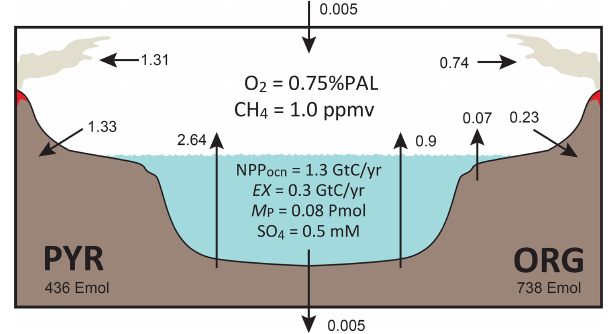
Figure 19. Schematics of global redox (O 2 ) budget for the f P = 1 . 6% ( = 10 − 1 . 8 ) run. Arrows represent the O 2 flux in terms of 10 12 molO 2 equiv.yr − 1 . PAL stands for present atmospheric level. Pmol is 10 15 mol. Emol is 10 18 mol. GtC is 10 15 gC. ORG rep- resents sedimentary organic C. PYR represents sedimentary pyrite S. NPP ocn is oceanic net primary production. EX stands for export production. MP is oceanic phosphate inventory. SO 4 represents the concentration of